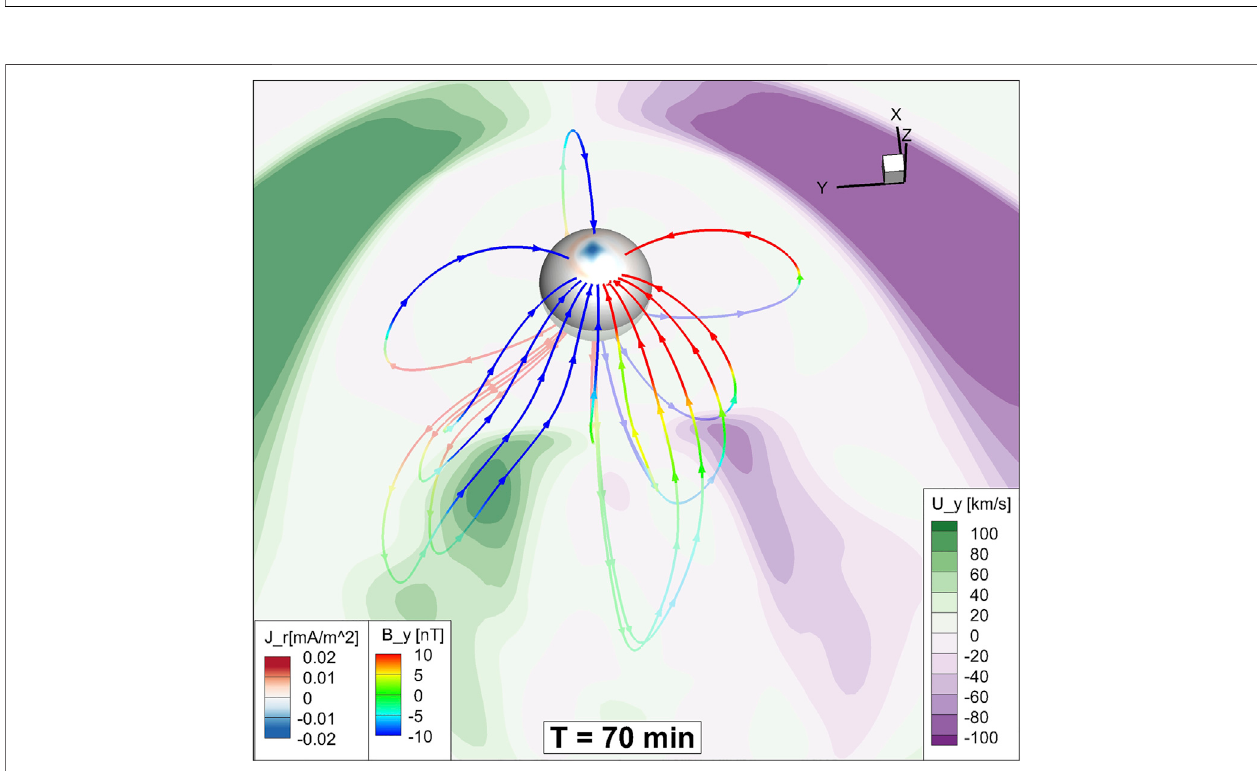
FIGURE 6 | Magnetic con fi guration at t = 70 min with the equatorial fl ow speed indicated by color.